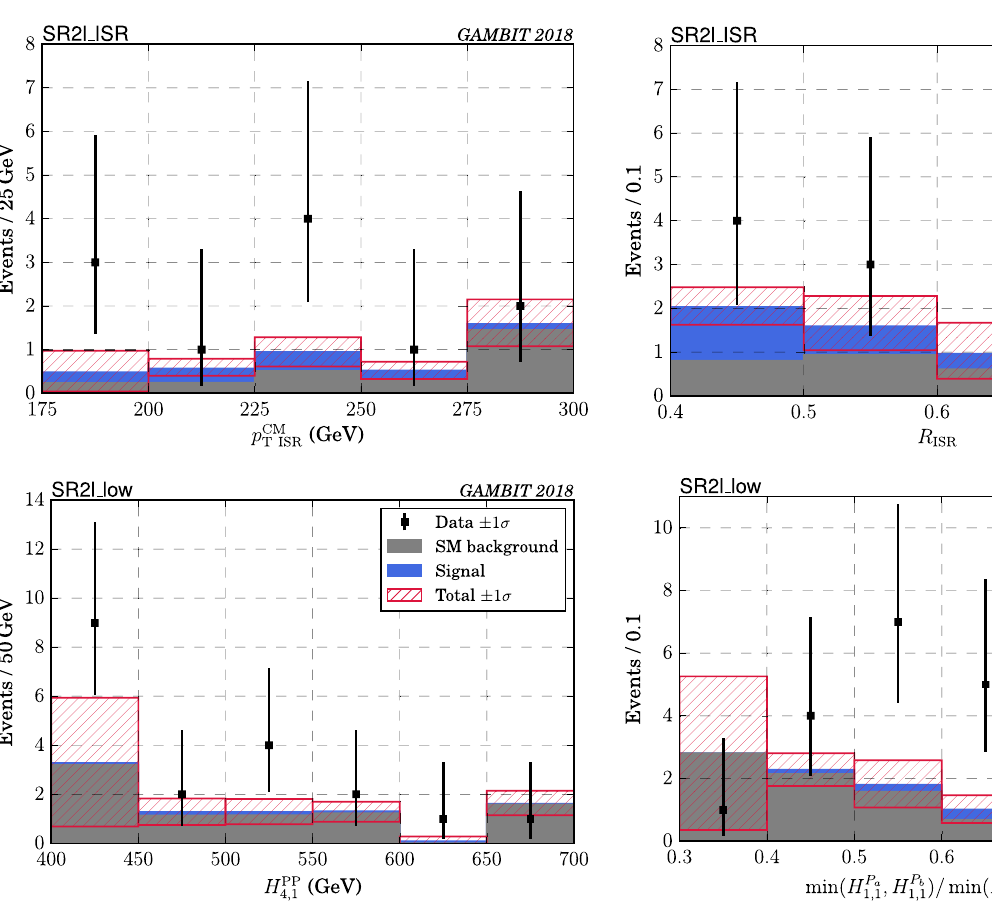
Fig. 13 Distribution of kinematic variables in the 2 lepton signal regions for the ATLAS RJ analysis, after applying all selection require- ments. The grey bars show the total SM background (taken from Ref. [117]) and the stacked blue bars show the signal for our best-fit point.